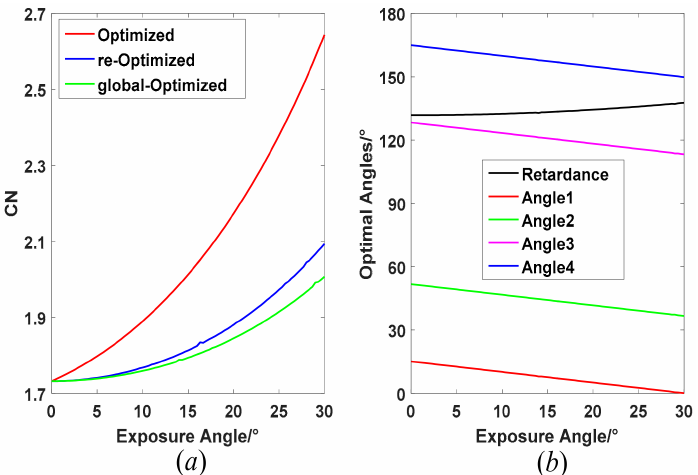
Figure 4. Global-optimized CN and its corresponding retardance and four nominal angles. ( a ) global- optimized CN; ( b ) global-optimized retardance and four nominal